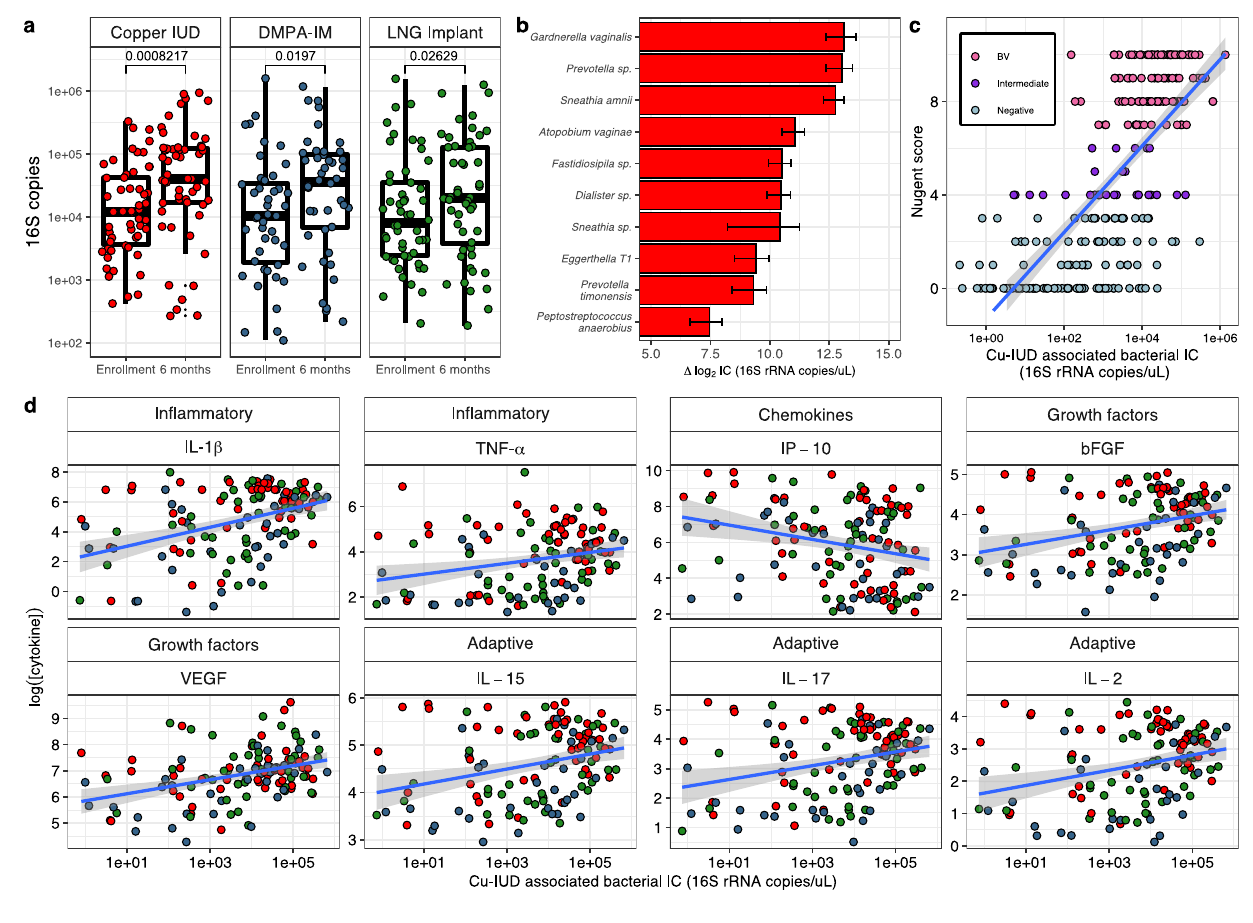
Fig.3|Cu-IUDuseinducessigni fi cantincreasesintheconcentrationsofseveral cervicovaginal bacteria and cytokines. a Absolute 16S rRNA gene copy number assessed by broad-range qPCR at the study enrollment visit and after 6 months of theassignedcontraceptiveuse. P valueswerecalculatedusingaStudent ’ sttestand corrected using the Benjamini and Hochberg method; Cu-IUD ( n =54); DMPA-IM ( n =44); LNG implant ( n =52). b Increases in absolute bacterial abundance after 6 months of Cu-IUD use. Only those taxa whose abundance remained signi fi cant after adjustment for multiple comparisons (Benjamini and Yekutieli) are shown. Data are presented as mean values+/ − SEM. c The additive concentration of bac- teria altered by Cu-IUD use correlates strongly with Nugent score. d The additive concentration of bacteria altered by Cu-IUD use correlates strongly with the